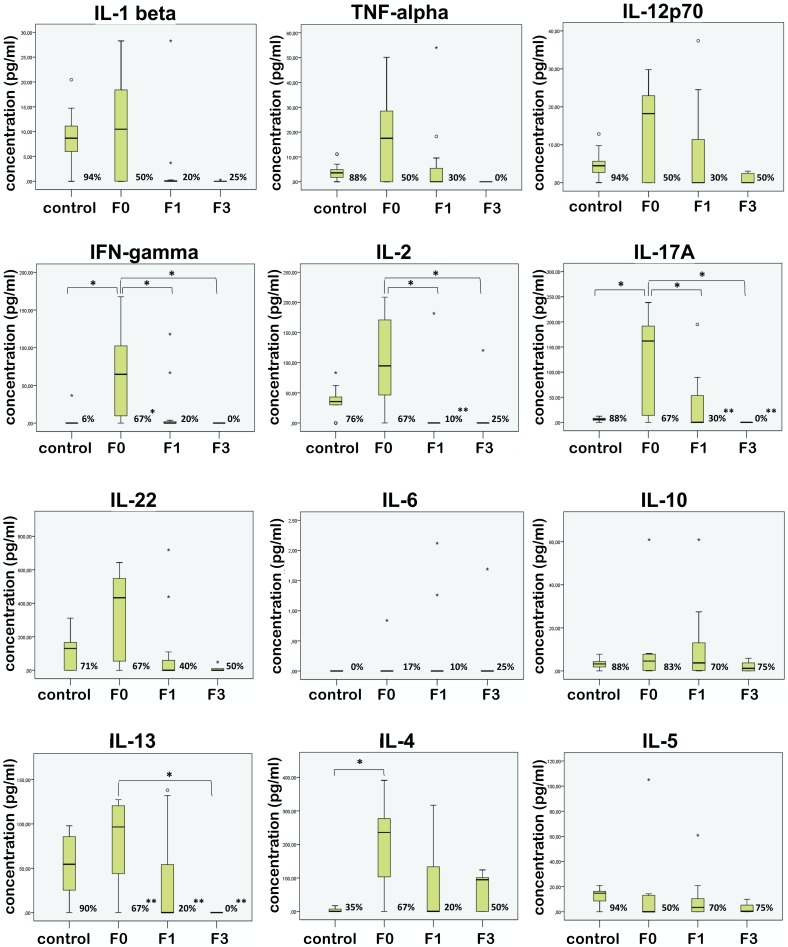
Box plots detailing sera cytokine levels in healthy controls and patients in different stages of fibrosis (F0, F1, F3).The numerals near the bars represent the percent of cytokine-producing subjects. Asterisk reflects significance of difference related to control: *p<0.05; **p<0.001.